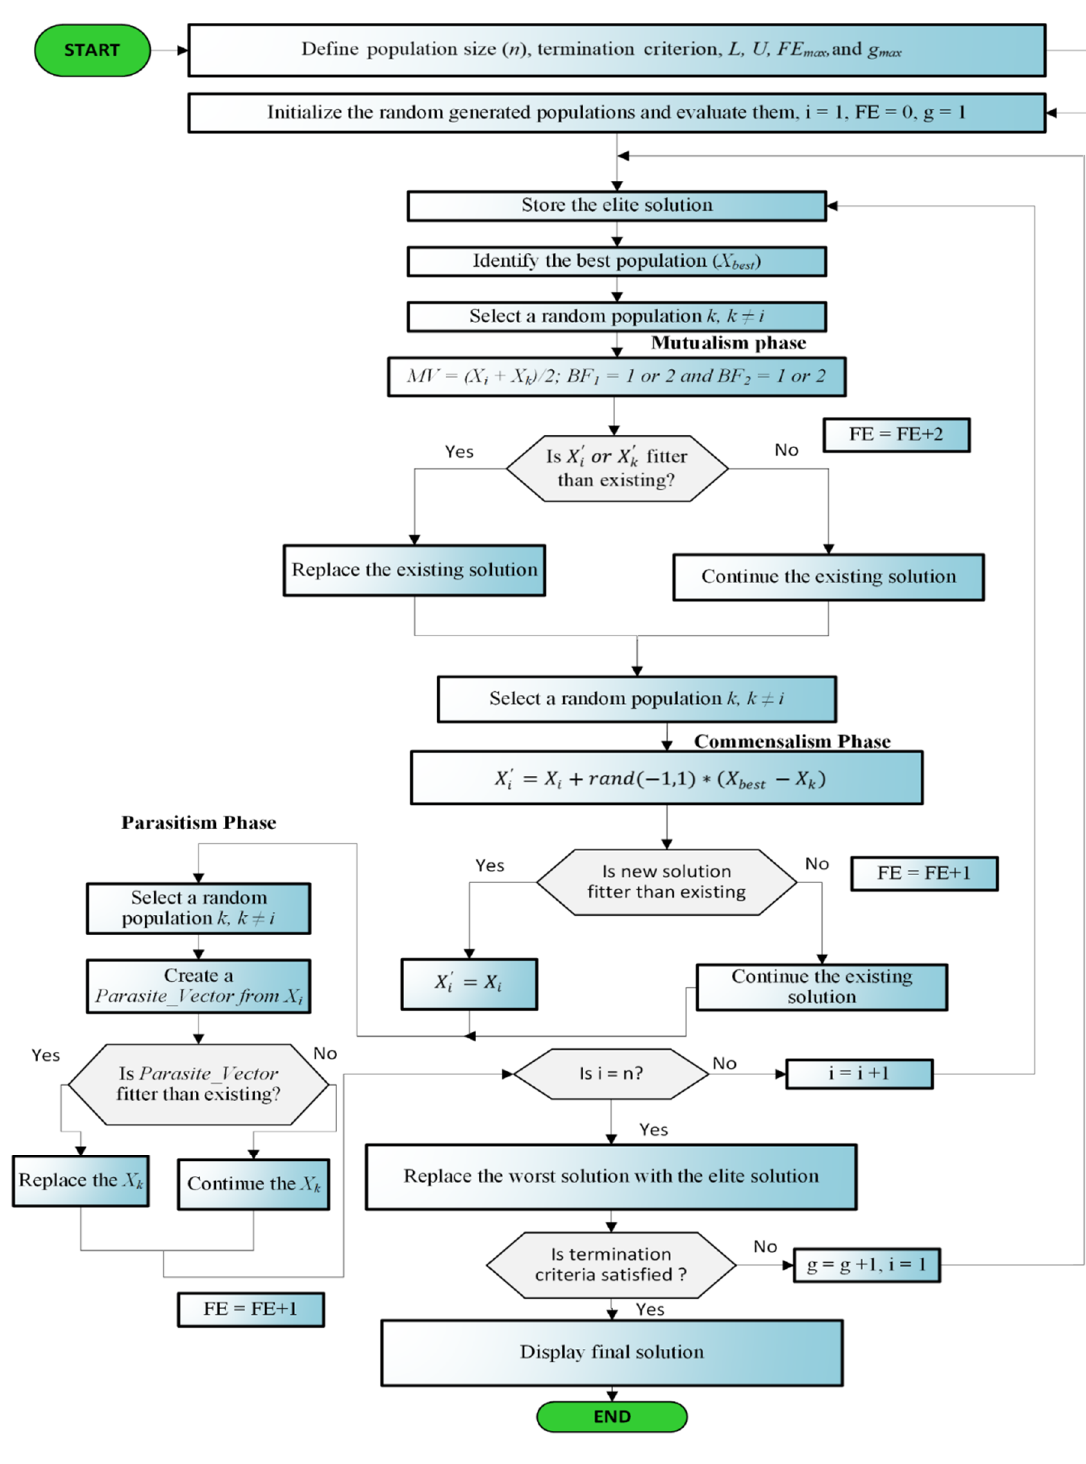
Figure 1. The SOS fl owchart.